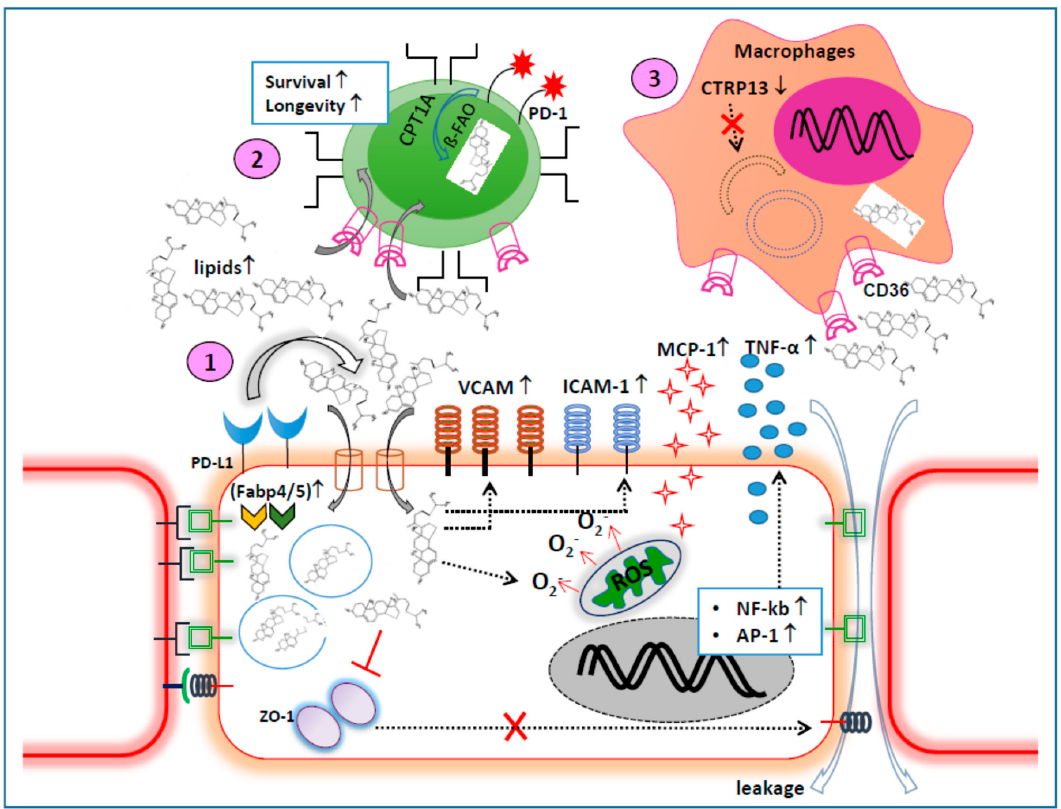
Figure 2. Possible mechanistic link between PD ‐ 1 and PD ‐ L1 molecules and an altered lipid metabolism on different types of cells during vascular inflammation. Possibly, (1) an increased uptake and intracellular accumulation of lipids in VECs might induce (i) oxidative stress to mitochondria as reflected by ROS production; (ii) cell surface expression of VCAM and ICAM ‐ 1 adhesion molecules; (ii) increased secretion of monocyte chemoattractant proteins (MCP ‐ 1); (iii) increased transcriptional factor NF ‐κ B and activator protein ‐ 1 (AP ‐ 1) expression; (iv) increased TNF ‐α levels; (v) decreased VEC tight junctional protein regulator, (ZO ‐ 1); (vi) enhanced permeability and increased VEC apoptosis. The lipid uptake by VECs is indeed aided by the increased PD ‐ L1 levels through the upregulation of fatty acid ‐ binding proteins (Fabp4/5). (2) The circulating lipids are also uptaken by bystander PD ‐ 1highCD8 + T cells that promotes fatty acid oxidation via carnitine palmitoyl transferase (CPT1A), the rate ‐ limiting enzyme of FAO, to sustain T cell survival and longevity. (3) Reduced CTRP13 in CAD macrophages prohibit the autophagy flux (AF) to clear the accumulated lipids that are taken via the scavenger receptor, CD36. This tends to load the CAD macrophage with circulating lipids to convert them into a foam cell, which is a key cell type with altered phenotype and metabolism in atherosclerotic plaques.